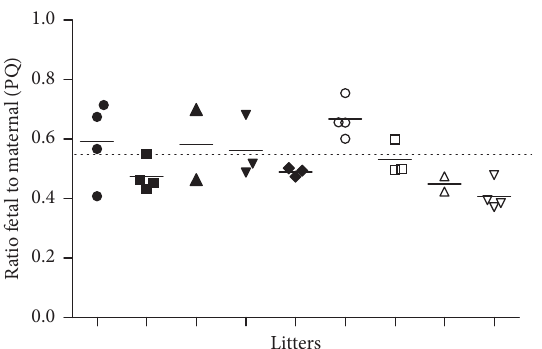
Figure 3: Transplacental transfer of primaquine (PQ). Ratios of fetal to maternal plasma concentrations of PQ in pregnant rats treated orally with PQ (40 mg.kg · bw − 1 ). Samples of maternal and fetal blood (2 to 4 fetal blood pooled samples per litter) were drawn 180min after PQ